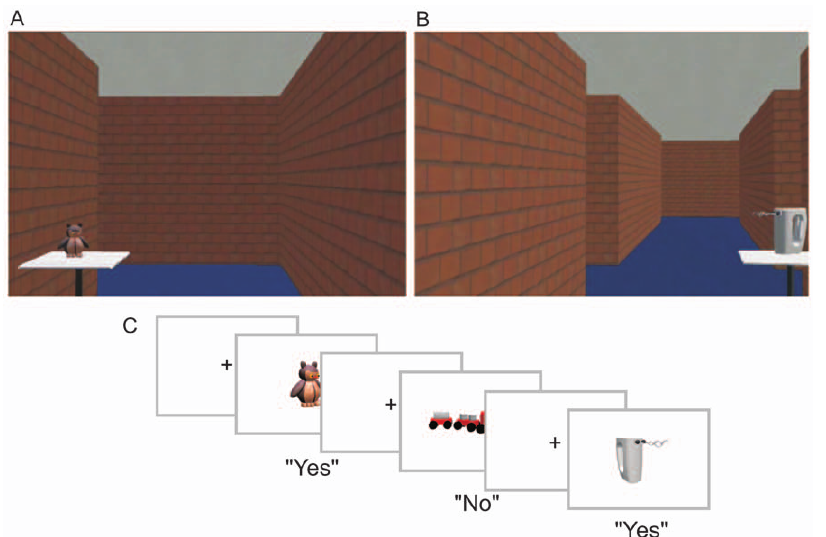
Figure 1. Stills from the virtual museum route showing a toy placed at a non-decision point (A) and a non-toy at a decision point (B), and schematic overview of the recognition trials (C). Participants had to indicate whether the presented object was shown in the movie or not by button press.